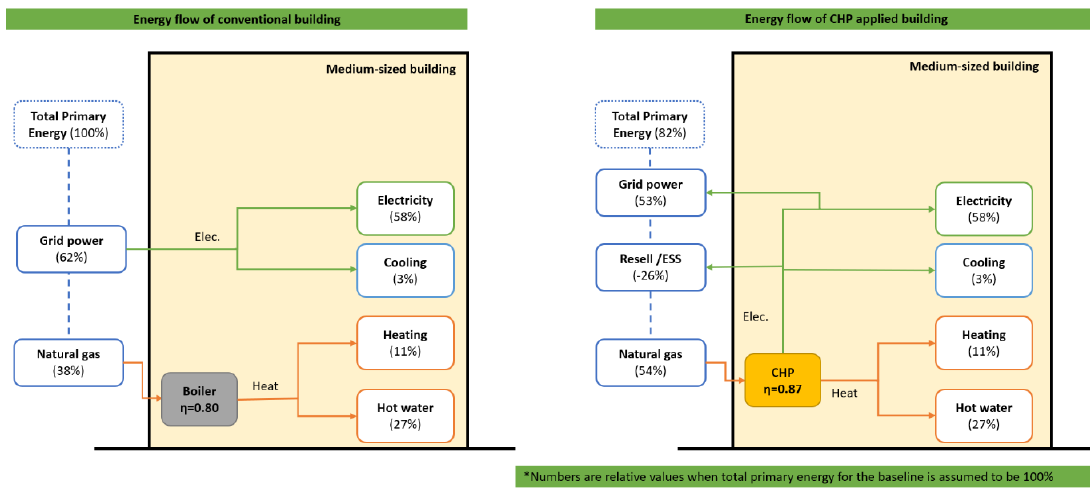
Figure 1. Comparison of energy flow in building without / with combined heating and power. Source: based on [11]